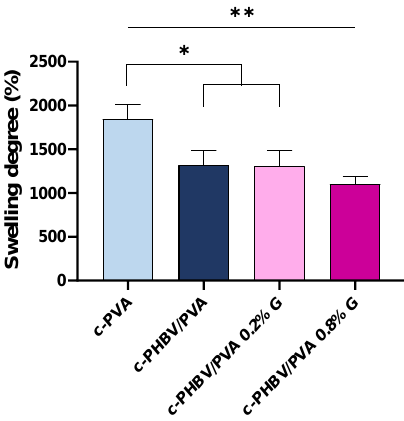
9 of 18 Figure 4. Fourier transform infrared spectroscopy (FTIR) spectra in the region 4000–300 cm −1 of the semi-IPN with and without G nanoparticles. Neat PVA, crosslinked PVA (c-PVA), and neat PHBV are also included as reference samples.